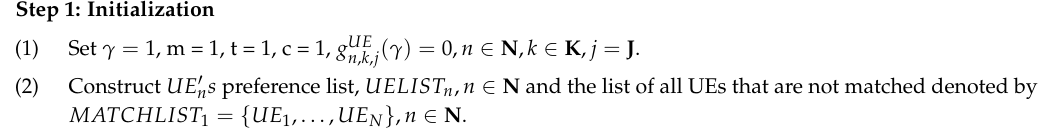
Algorithm 2 The bilaterally matching algorithm between BS-SUBs and